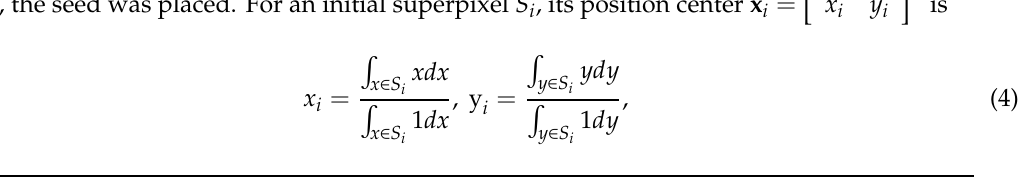
Algorithm 1. Seed sampling